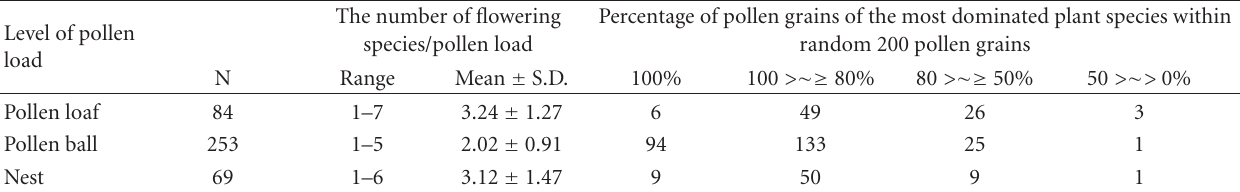
Table 1: Composition of pollen grains ( n = 200) randomly chosen from each of 84 pollen loads and 253 pollen balls. Level of pollen